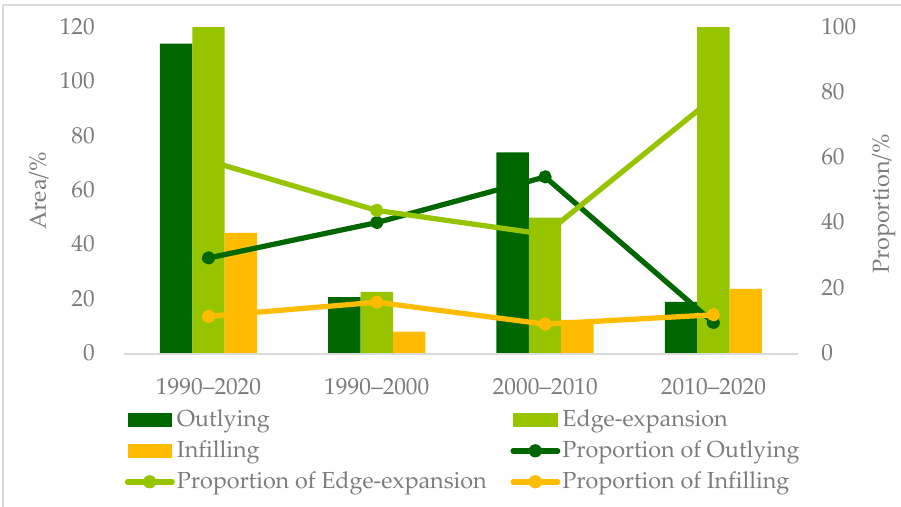
Figure 4. Percentages of the three spatial growth types during 1990–2020.